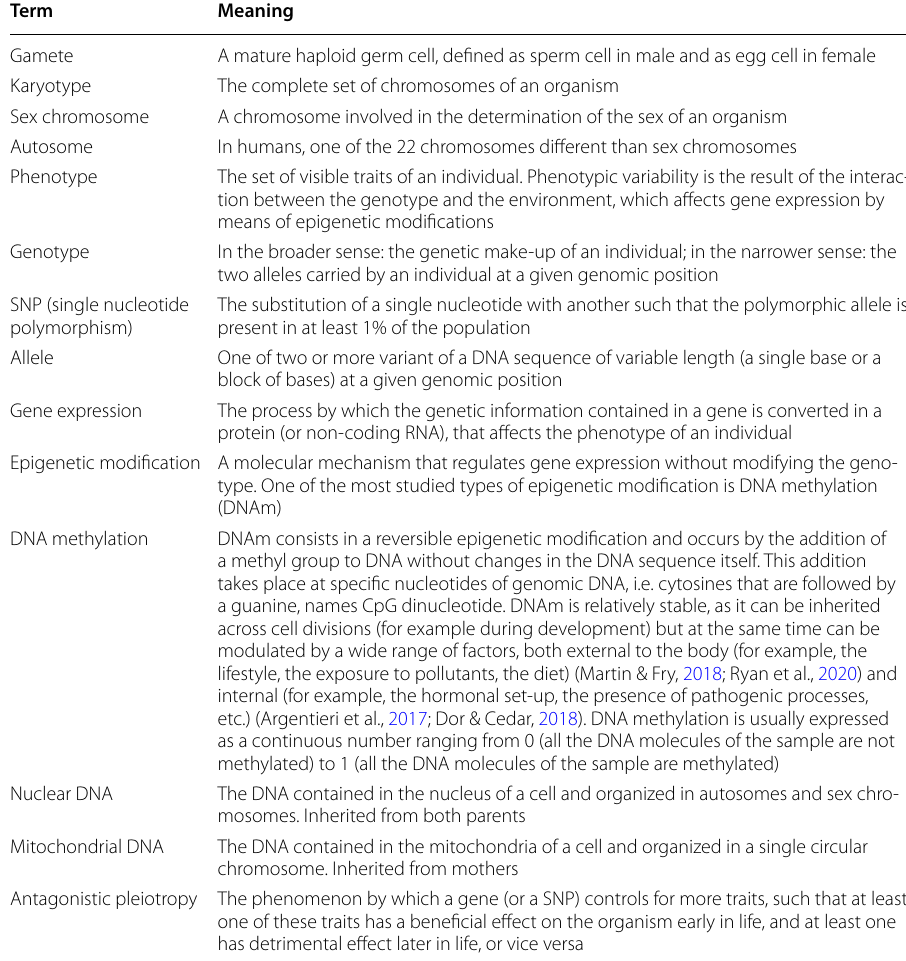
Table 1 Glossary of the biological concepts used in the text Term Meaning